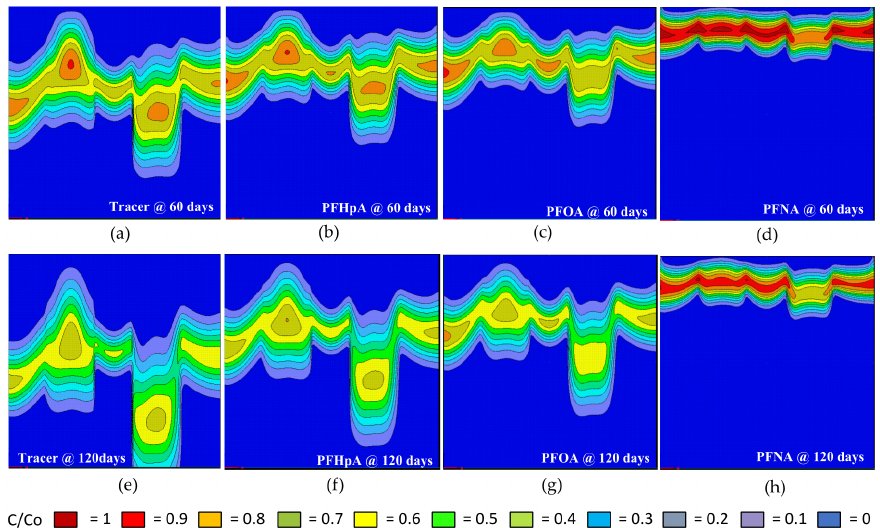
Figure 13. 2D-simulated transport of PFCAs under periodic water application at the upper boundary: ( a and e ) non-reactive tracer at 60 and 120 days; ( b and f ) PFHpA at 60 and 120 days; ( c and g ) PFOA at 60 and 120 days; ( d and h ) PFNA at 60 and 120 days. AWI adsorption is the only source of retention. Concentrations as relative concentration (C / C o ) where initial concentrations (C o ) were 1 mg / L for each